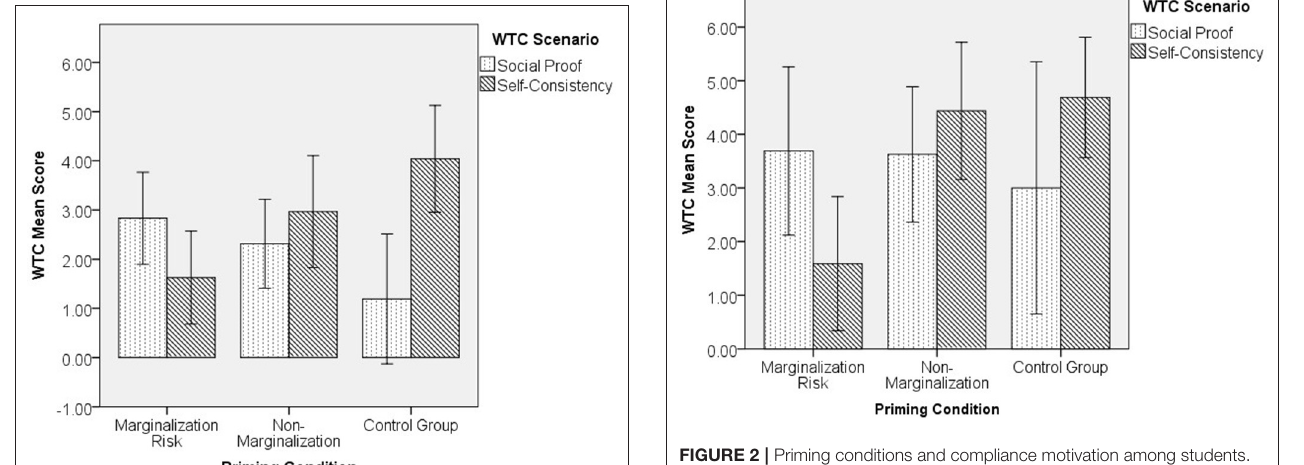
FIGURE 2 | Priming conditions and compliance motivation among